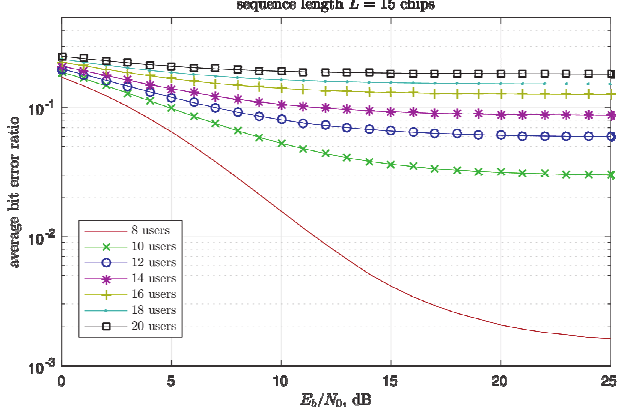
Fig. 6. Asynchronous DS-CDMA: BER performance in case of 15-chip-long chaotic spreading sequence.